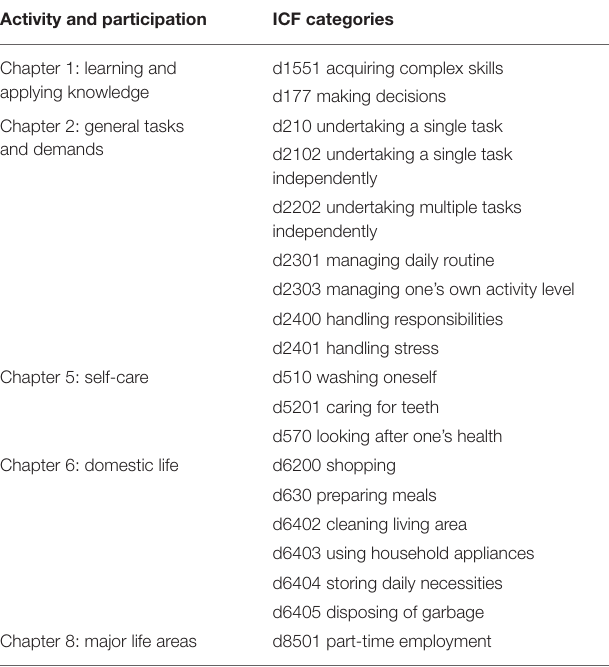
TABLE 3 | A preliminary set of ICF categories for rehabilitation goals in community rehabilitation for persons with neurological diseases. Activity and participation